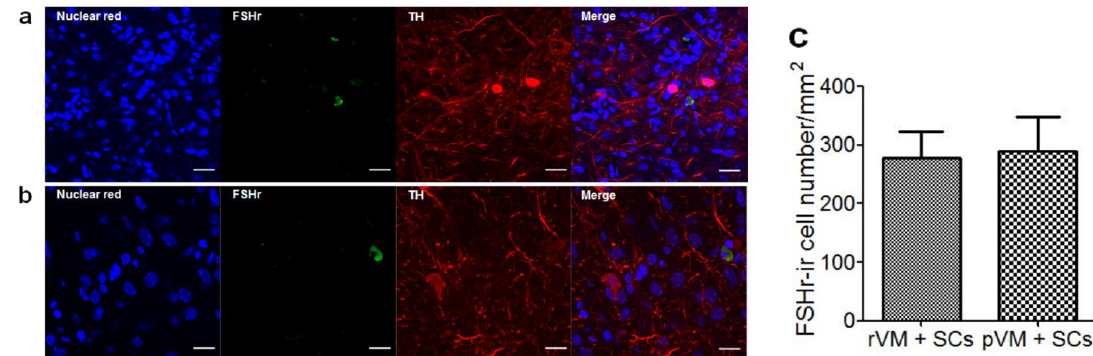
Figure 7. SCs and DA cells co-existed in the grafted striatum of the rVM+SCs and pVM+SCs groups four weeks after transplantation. Brain sections were stained with a dopaminergic neuron marker (TH) and SCs marker (FSHr). ( a ) rVM+SCs group. ( b ) pVM+SCs group. ( c ) Quantification data of FSHr-ir cell numbers. Scale bar = 20 µ